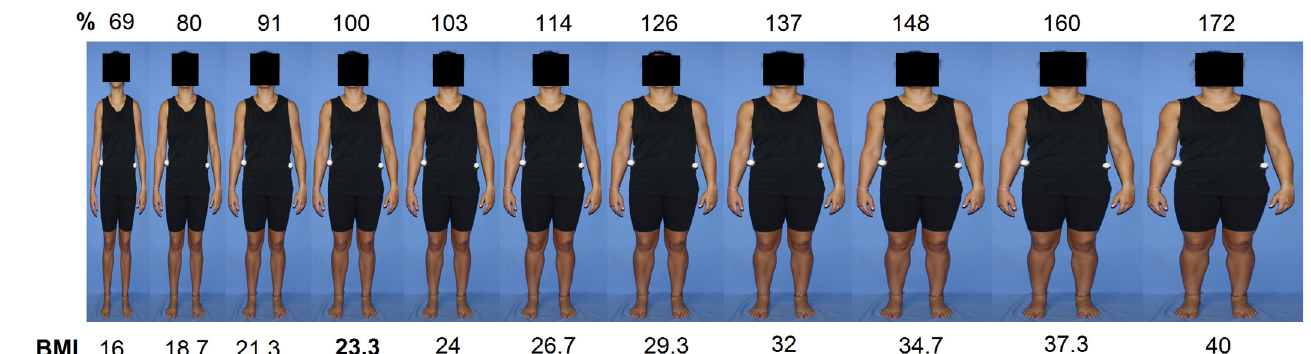
Figure 1. Scale of distorted images of a female participant’s body, including the actual, undistorted image (i.e., 100% or BMI =